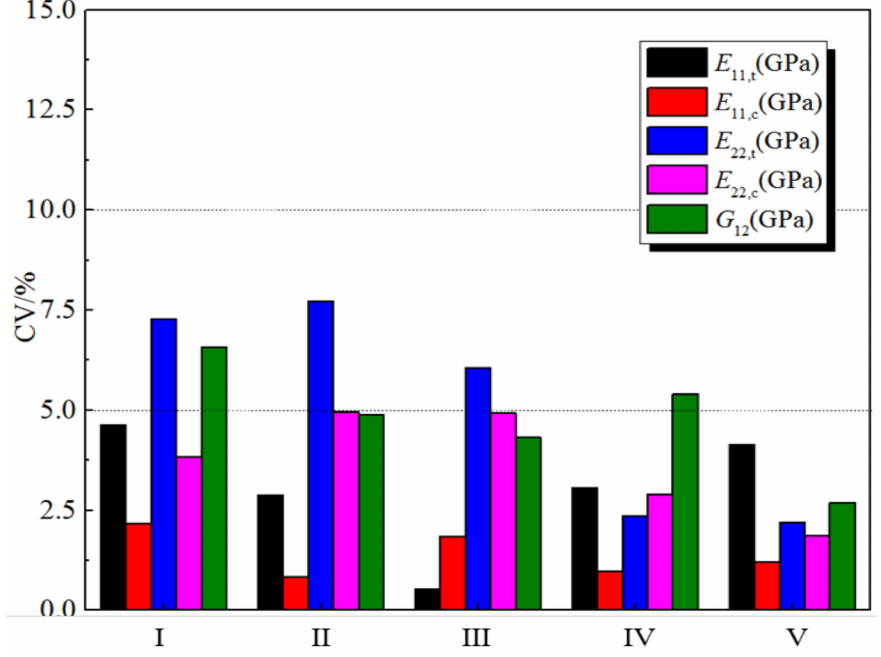
Figure 2. Coefficient of variation (CV) for the stiffness properties of the five H-GFRP